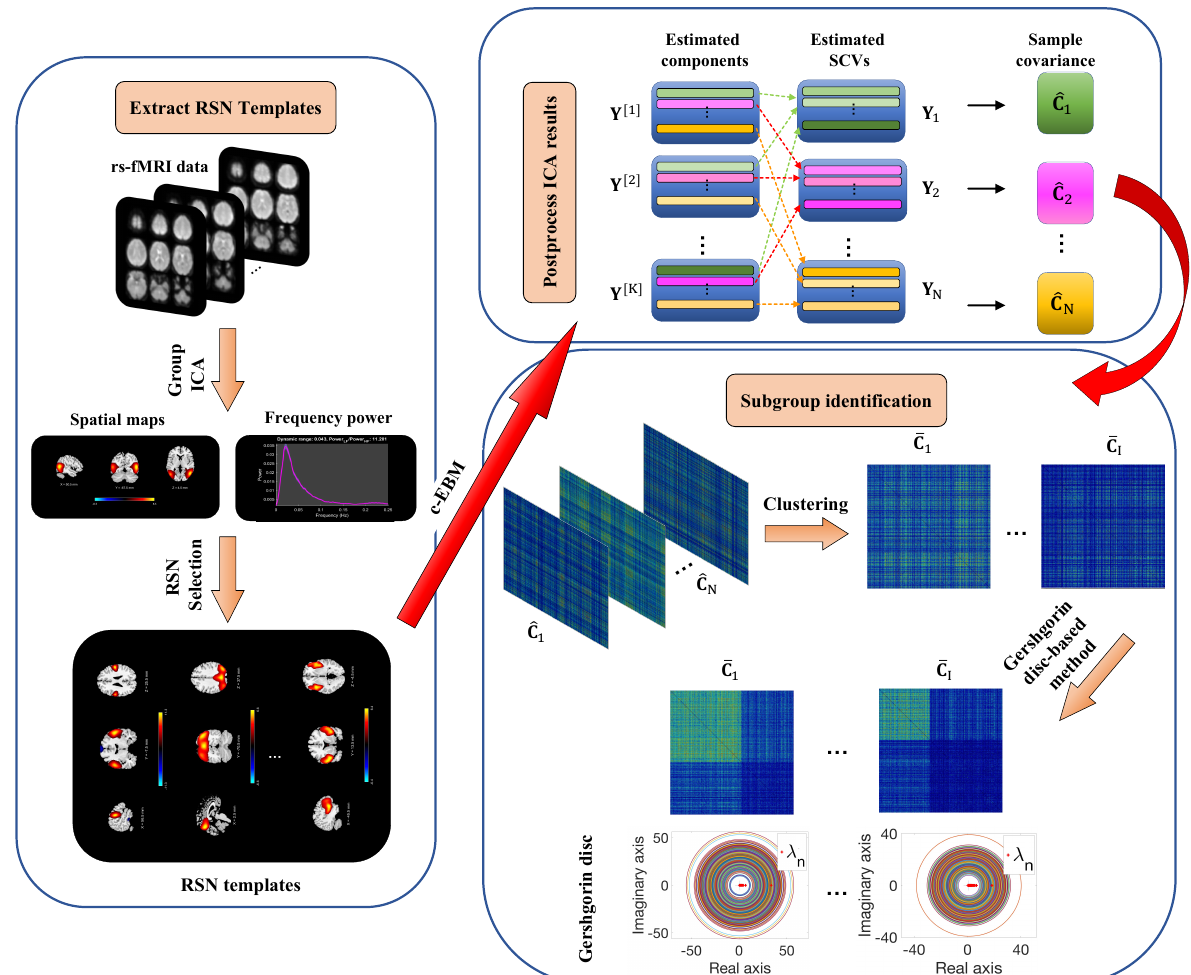
Figure 1. Flowchart of the proposed subgroup identification pipeline, fSIG. Step 1: Extract the resting- state network (RSN) templates by applying group ICA-EBM on an independent dataset